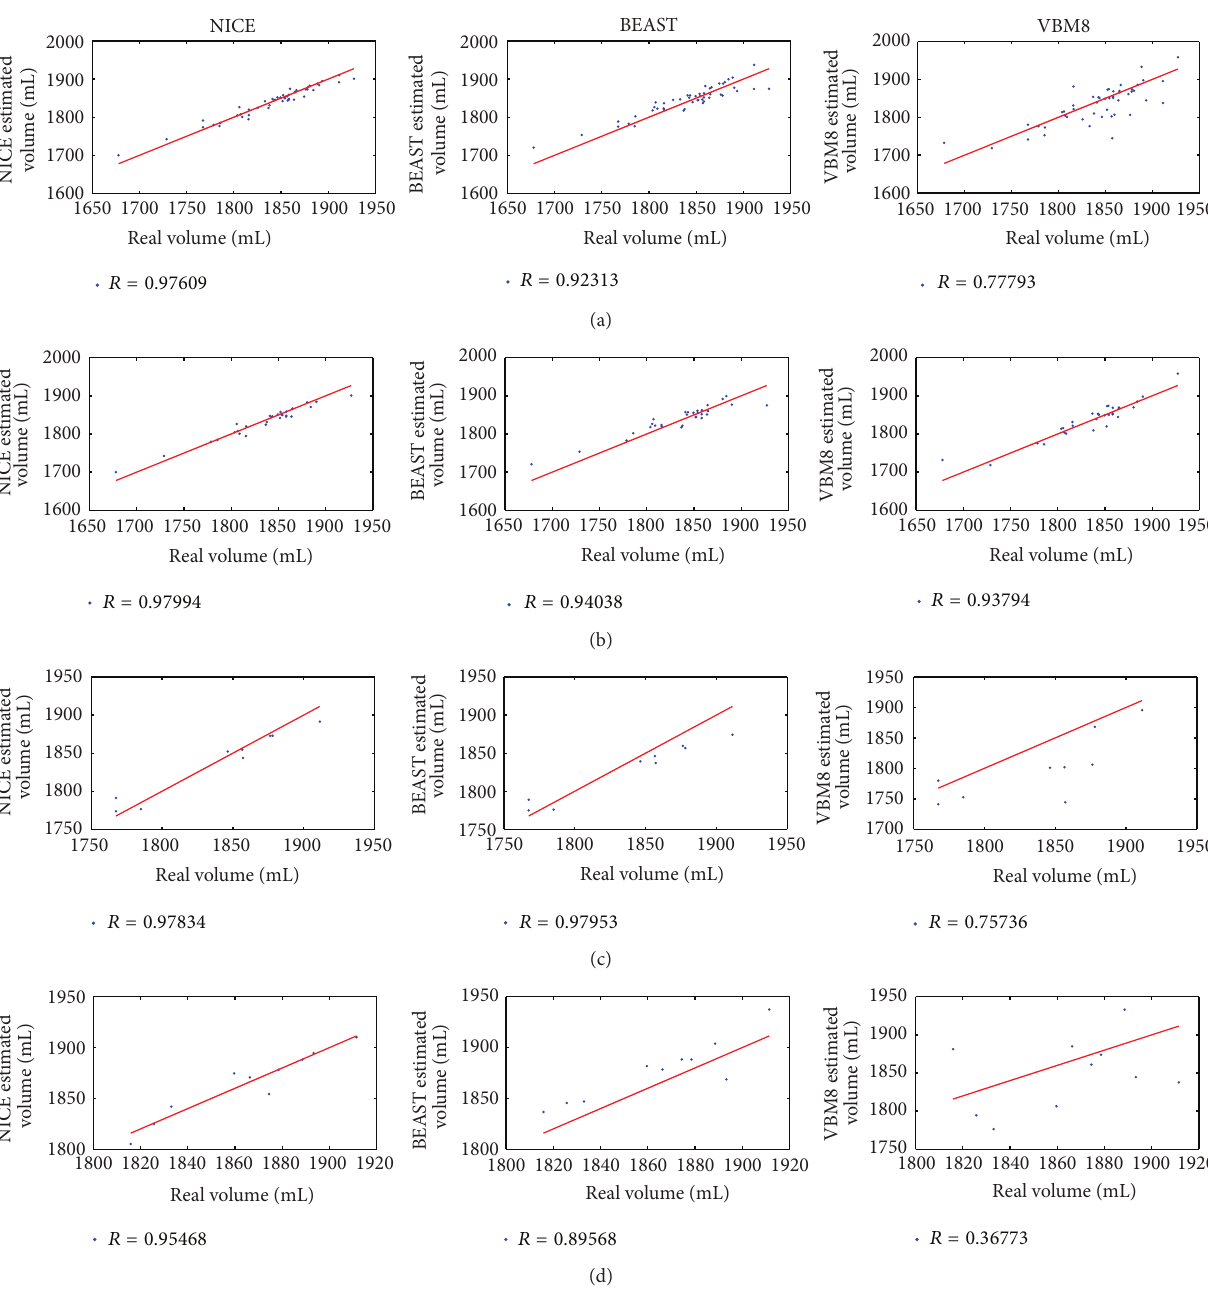
Figure 5: Comparison of intracranial cavity volume estimation results. Automatic versus manual volume correlation for all the compared methods and datasets used. The first row shows results for the whole library ( 𝑁 = 49 ), the second only for normal adults ( 𝑁 = 30 ), the third only for AD subjects ( 𝑁 = 9 ), and the fourth only for infant cases ( 𝑁 = 10 ). Red line represents ideal mapping between estimated and real volumes to highlight eventual over or under volume estimations (it does not represent the fitting